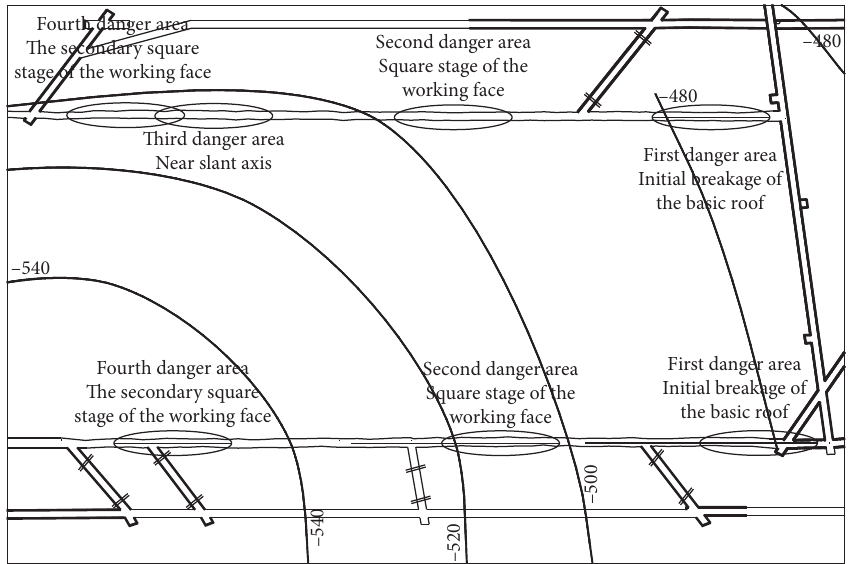
Figure 1: Risk area division of rock burst in LW 8101.